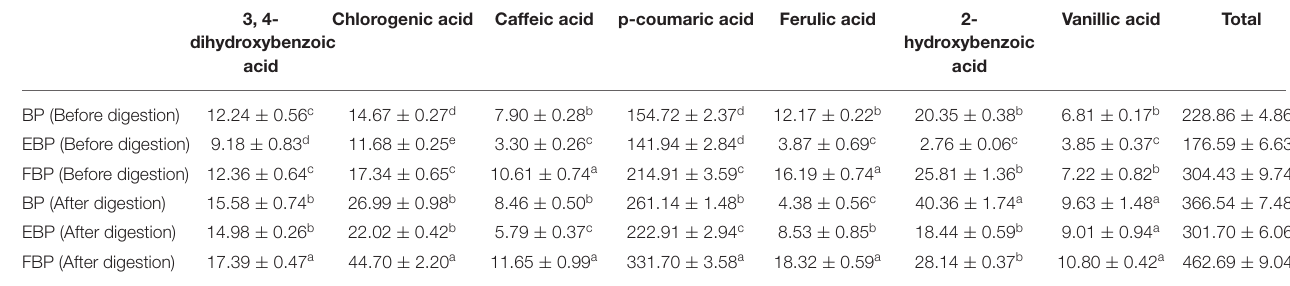
TABLE 8 | The content of phenolic compounds before and after digestion in vitro . 3, 4- Chlorogenic acid Caffeic acid p-coumaric acid Ferulic acid 2- dihydroxybenzoic acid